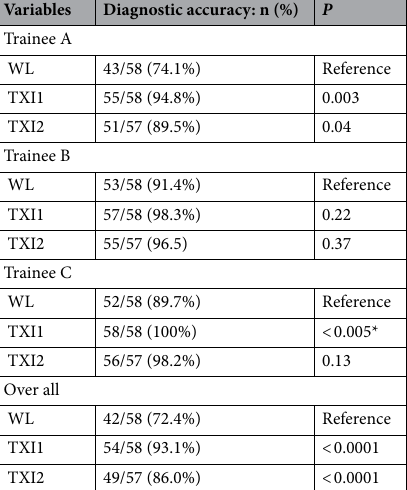
Table 3. Diagnostic accuracy of WL, TXI1 and TXI2 across three different trainees. *Statistical analysis was performed using the binomial test. All other associations were determined using the McNemar’s test. TXI2 could not be performed for one